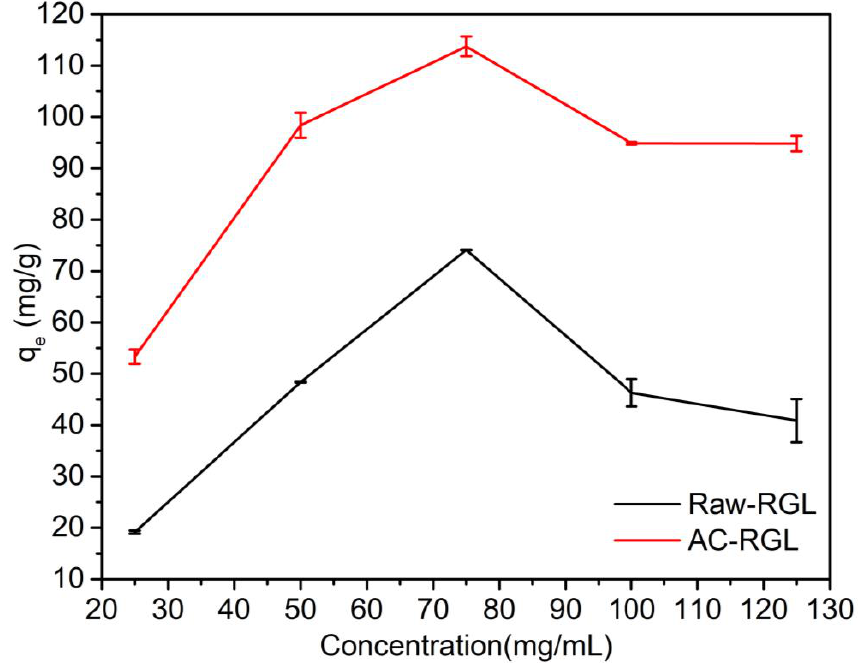
Figure 6. Effect of concentration on ibuprofen uptake by Raw-RGL and AC-RGL adsorbents. Table 4. Adsorption isotherms of Raw-RGL and AC-RGL and